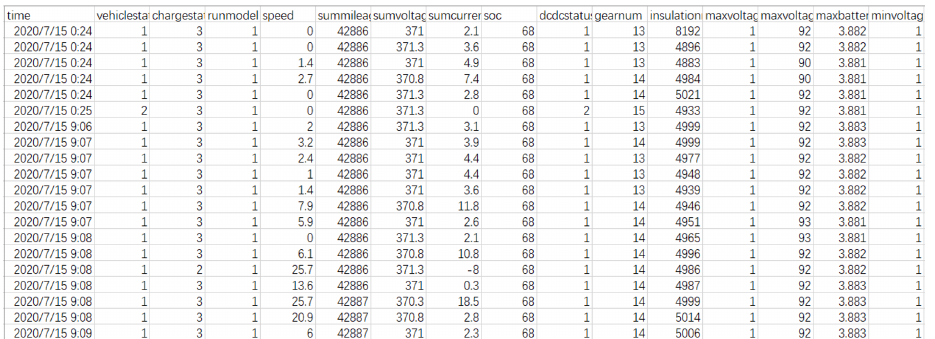
Figure 2. New energy vehicle battery dataset 2